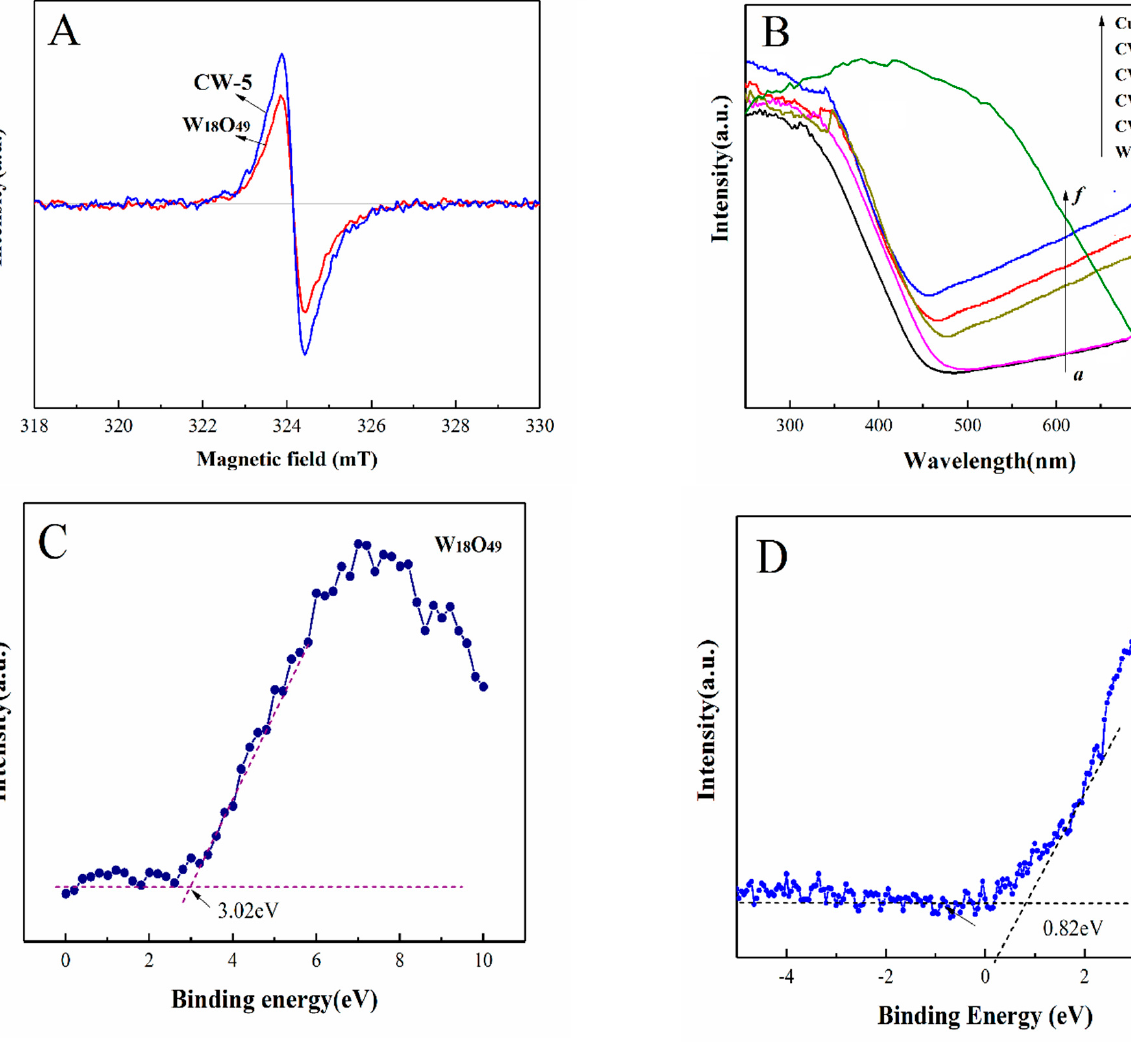
Figure 4. ( A ) ESR spectra of W 18 O 49 and CuO/W 18 O 49 samples; ( B ) Ultraviolet–visible diffuse reflectance spectra of W 18 O 49 and CuO/W 18 O 49 samples. ( C ) XPS VB spectra of W 18 O 49 sample; ( D ) XPS VB spectra of CuO sample.